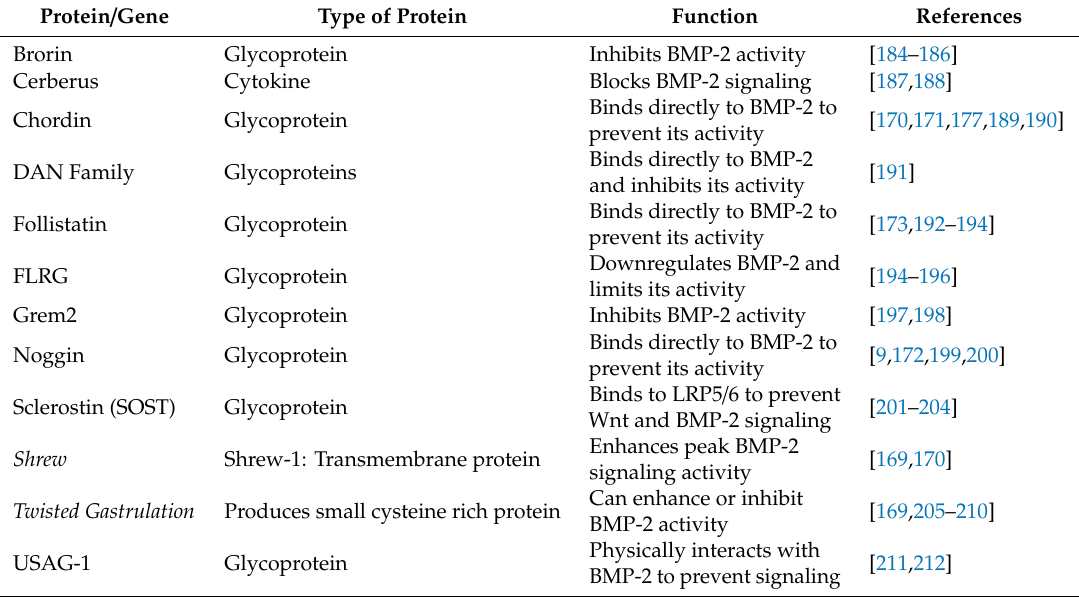
Table 1. Known agonists and antagonists of